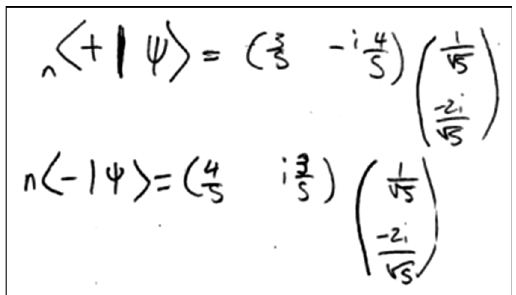
FIG. 2. Student work showing the start of the projection method of finding a change of basis. The student began by writing the inner products and expanding into matrix